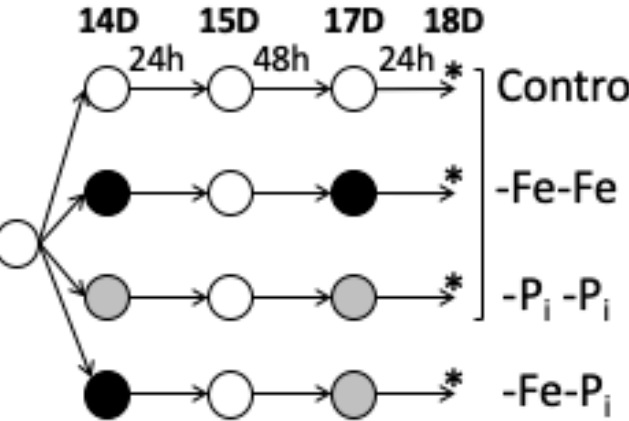
Figure 1. Experimental Design. Plants were sown in germination paper for seven days (D) and then transferred to full nutrient hydroponic solutions as described by [35]. The plant age (14D, 15D, 17D, and 18D post-germination) at corresponding experimental timepoints is provided at the top of the figure. At 14 days (14D), plants were moved to new nutrient solutions. Iron deficient (-Fe) nutrient solution, phosphate deficient (-P i ) nutrient solution and full nutrient solution are indicated by black, grey and white circles, respectively. After 24 hours (h), all plants were moved to new full nutrient solutions for 48 h before a final move to new nutrient solutions for 24 h. At the end of the second 24 h stress exposure, leaf and root samples were harvested, denoted by an asterisk (*). For each tissue all 12 samples were grown, harvested, extracted, sequenced, and normalized together. Samples within bracket were analyzed and described in an earlier publication, [34]. However, to understand the biological importance of this treatment requires a comparison to previously published data.